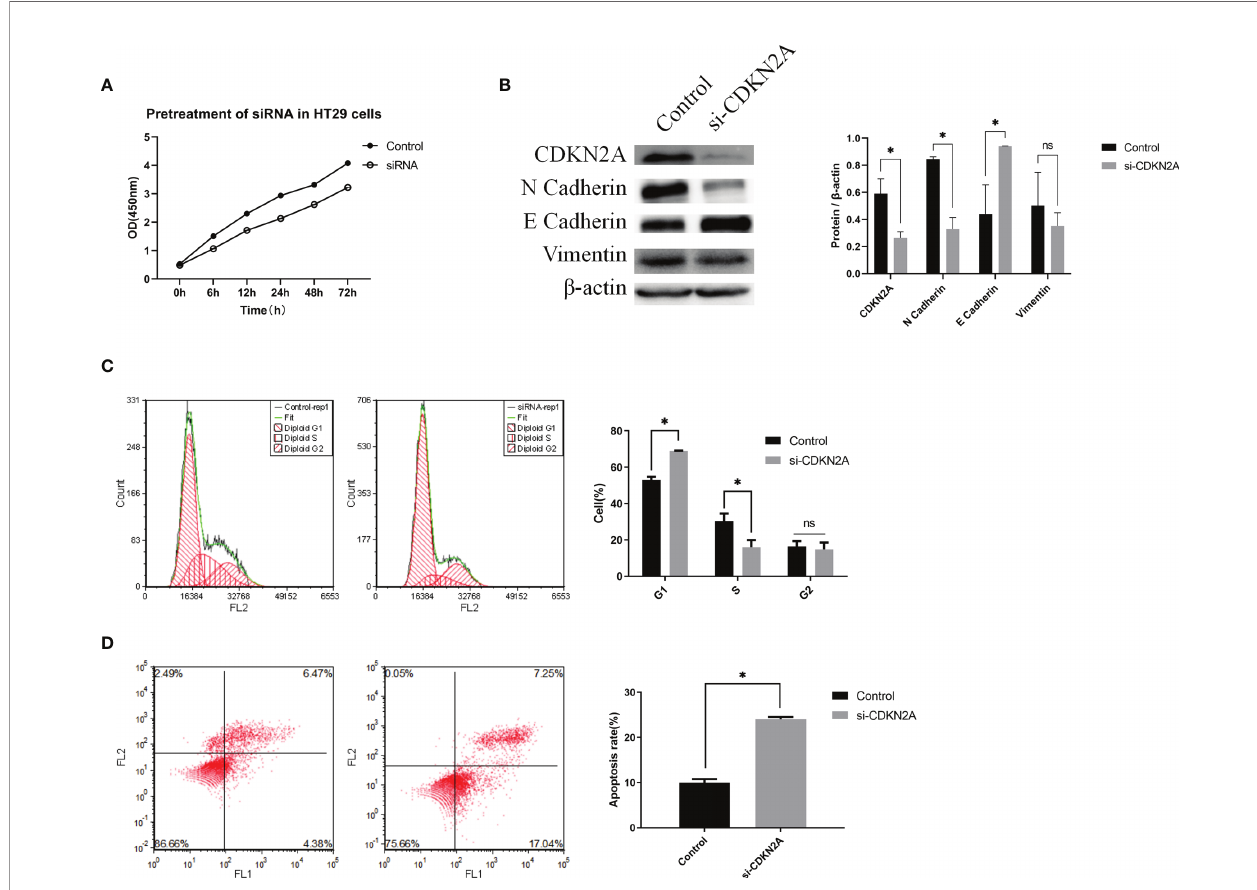
FIGURE 6 | In vitro experiments validating the biological role of CDKN2A. (A) CCK-8 assay; (B) Protein expression of CDKN2A, E-cadherin, N-cadherin, and vimentin. (C) Flow cytometric analysis of the cell cycle and statistical results of the cell cycle; (D) Flow cytometric analysis of apoptosis and statistical results of apoptosis; The results are shown as the mean ± SD of the data from three sets of replicate experiments, *P < 0.05, ns, non signi fi